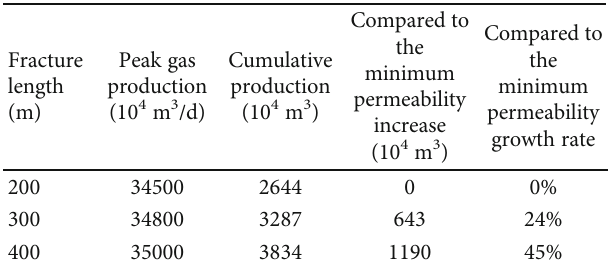
Table 7: Peak and cumulative gas production at di ff erent fracture